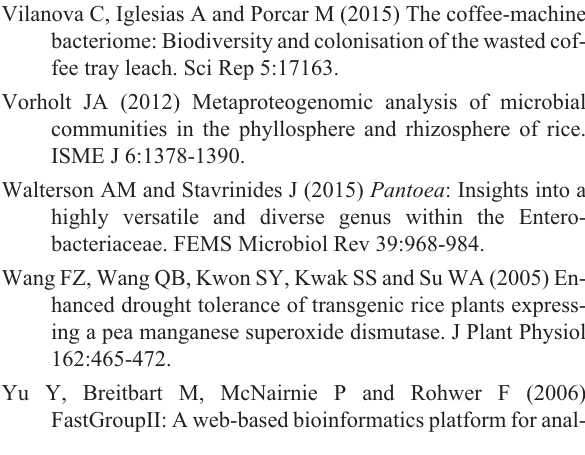
Figure S1: Amplicons of fragments of both plant and bacte- rial 16S